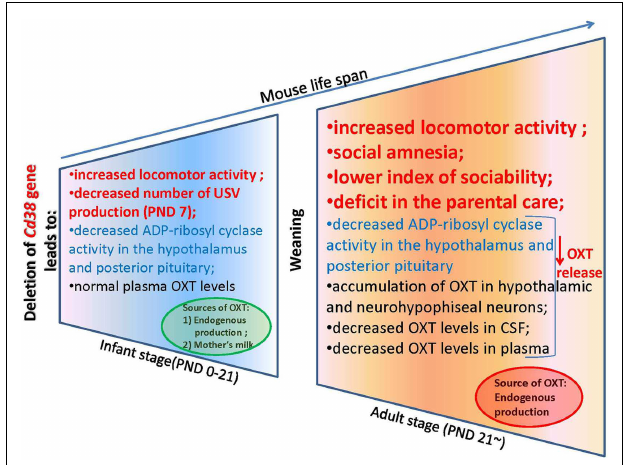
FIGURE 3 |An oxytocin release feedback loop and potential molecular targets for pharmacotherapy of alterations in social behavior.